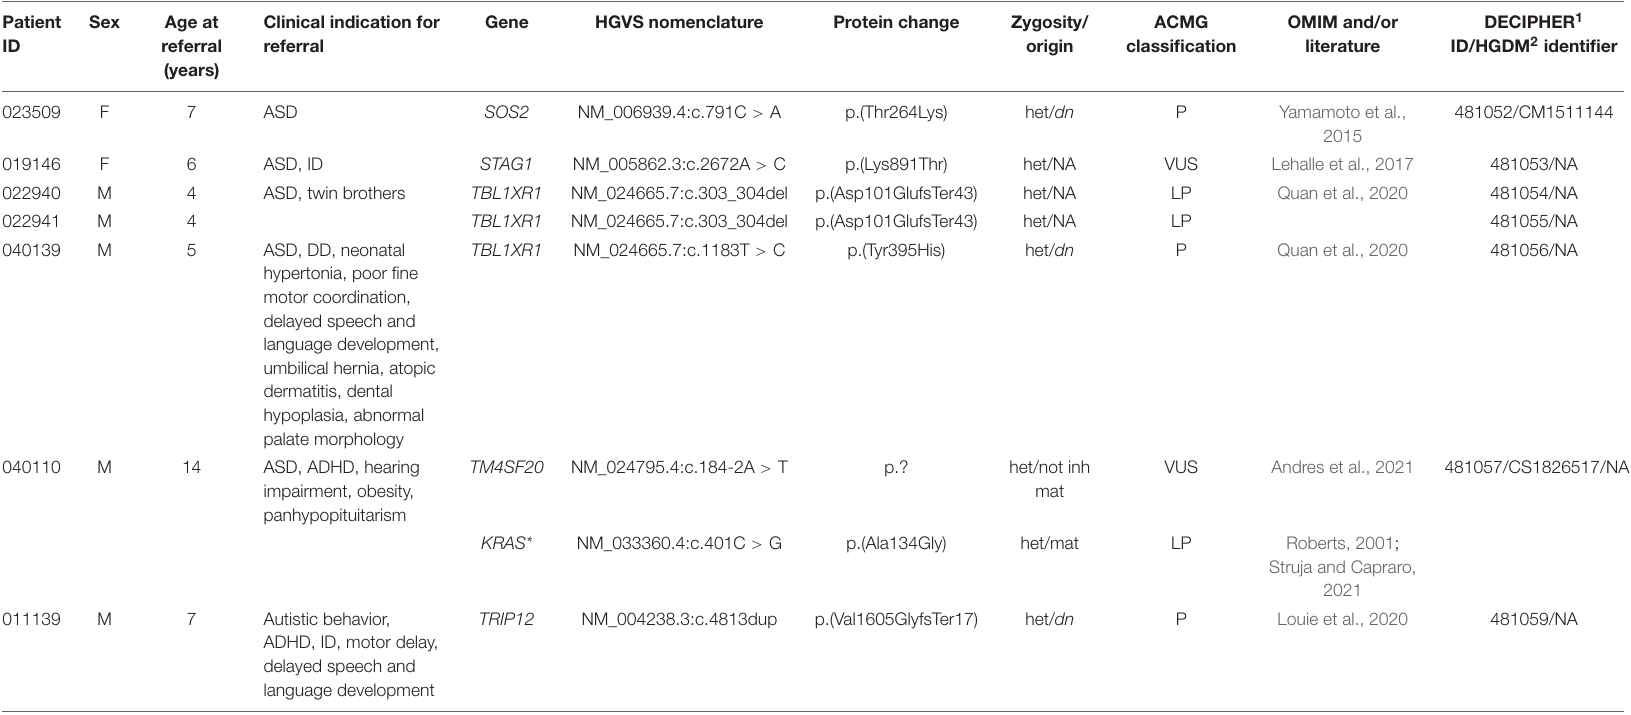
a Synonymous variant with potential altered splice effect. b Observed positive family history. ∗ NDD-associated genes not listed in the SFARI gene list. HGVS, Sequence Variant Nomenclature; het, heterozygous; hemy, hemizygous; NA, not available; dn, de novo; mat, maternal; pat, paternal; not inh mat, excluded in the mother; P, pathogenic; LP, likely pathogenic; VUS, variant of unknown